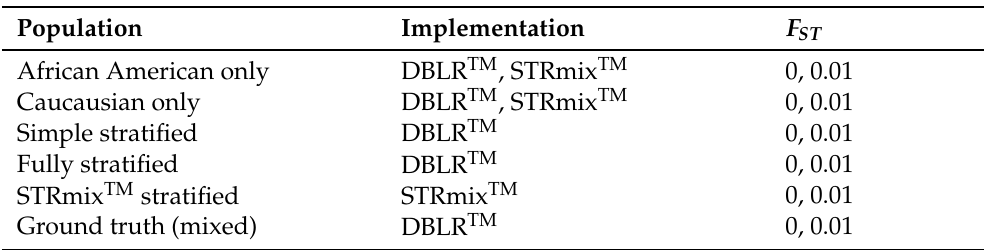
Table 3. Overview of likelihood ratios calculated for comparison of each of the 500 true donors to the 250 simulated two-person